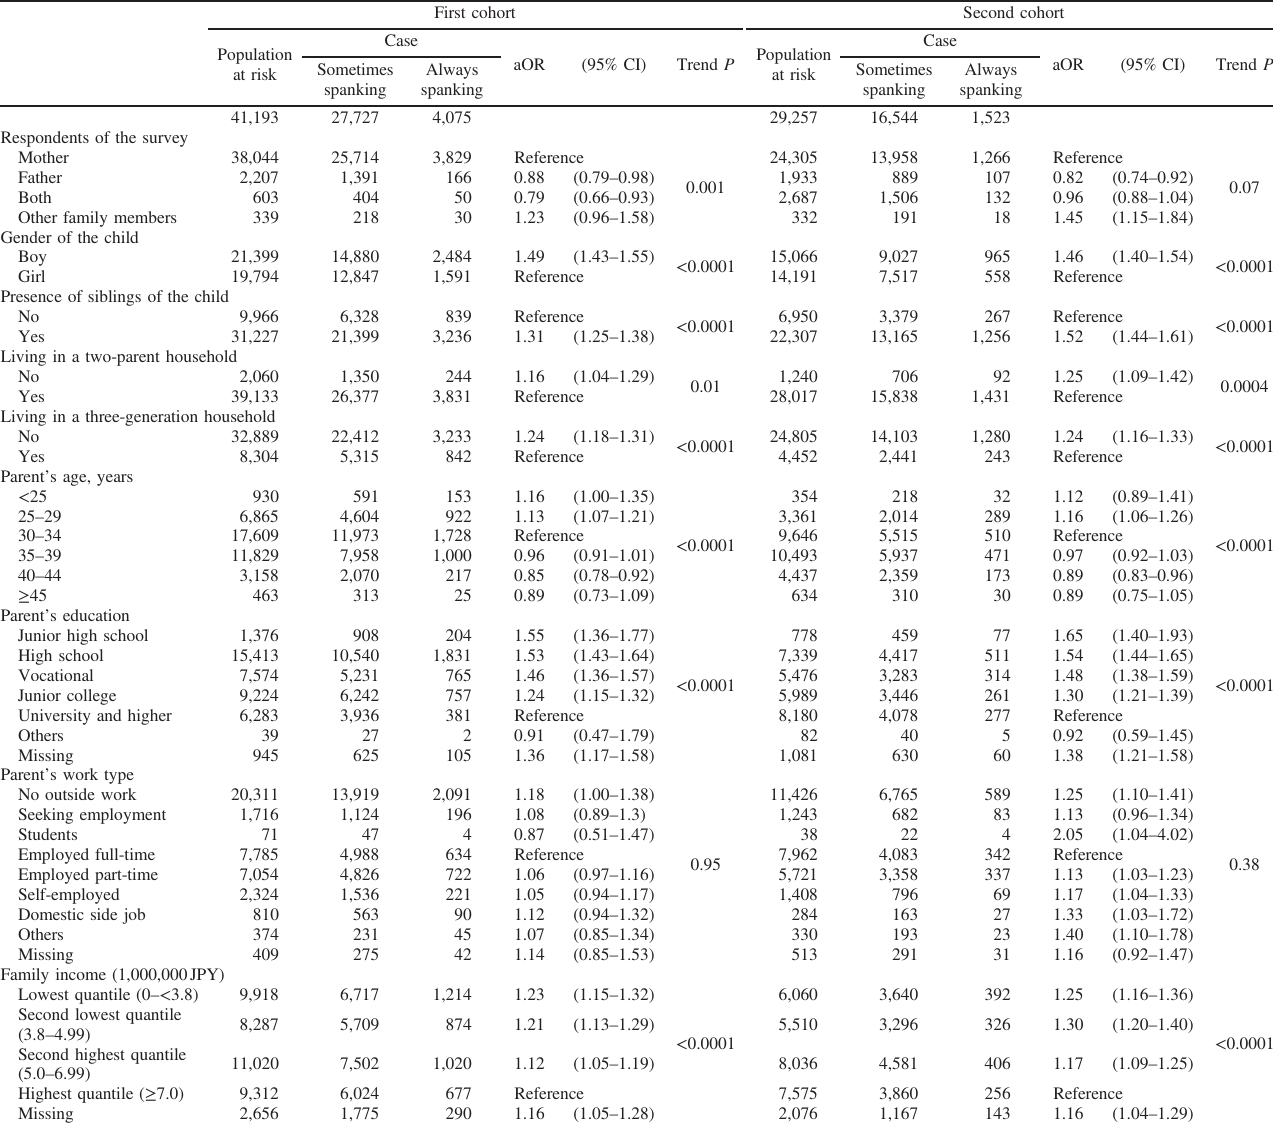
Table 4. Adjusted a odds ratios for spanking strati fi ed by cohort generation